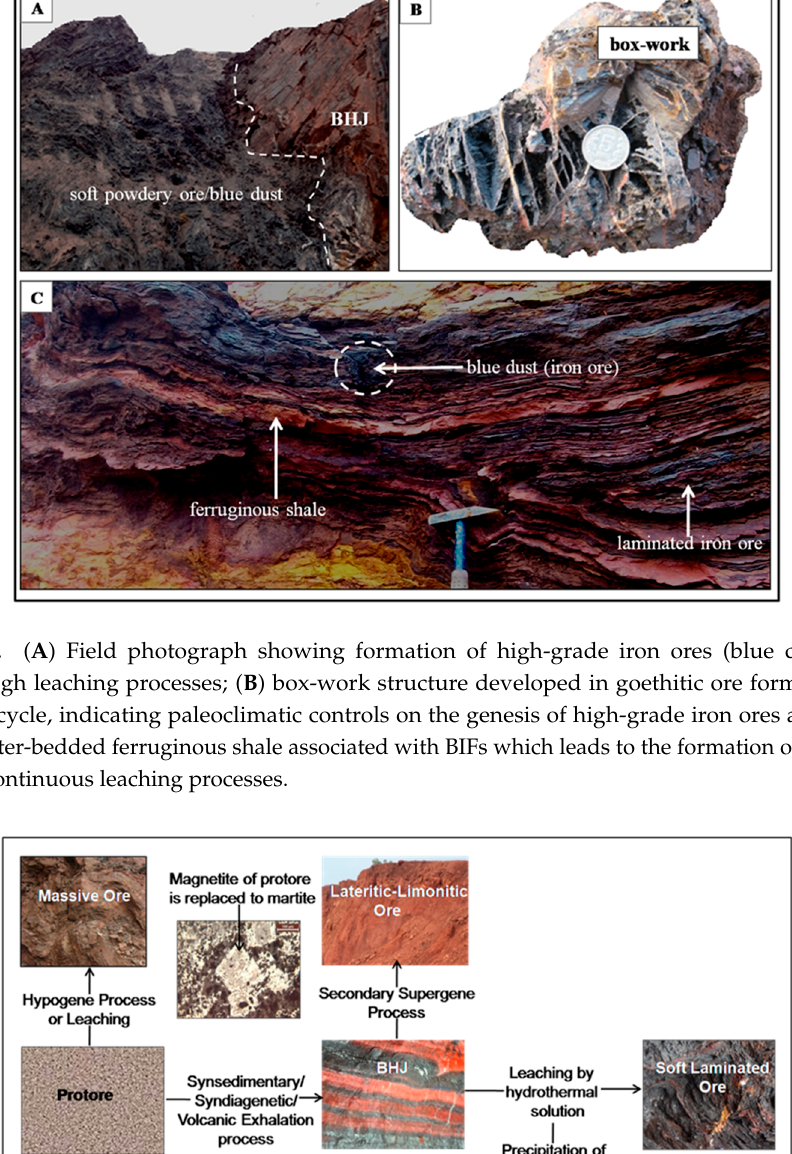
Figure 12. Schematic diagram showing possible evolution of different types of iron ores at KMIOD from proto-ore and BHJ aided by the rheological features of various lithological units modified after [9,34].